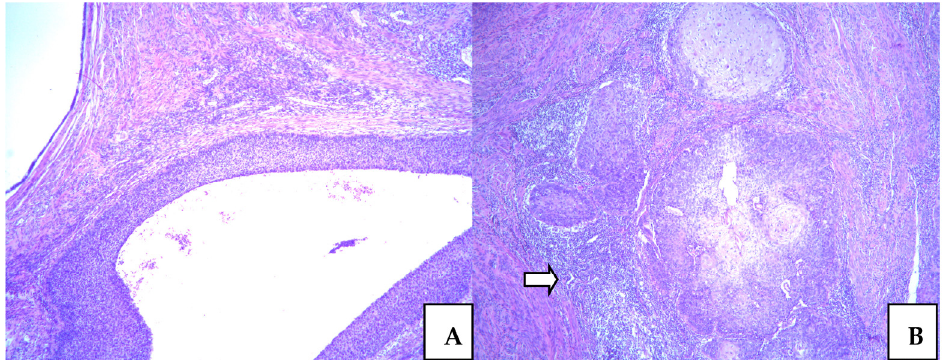
Figure 2. Squamocellular carcinoma in the cervix uteri. High grade epithelial displasia (H-SIL) surronding with tumor free endocervical tissue with inflammatory changes (( A ). ×50); Squamocellular in situ cevical carcinoma with microinvasive foci (arrow) (( B ). ×50).